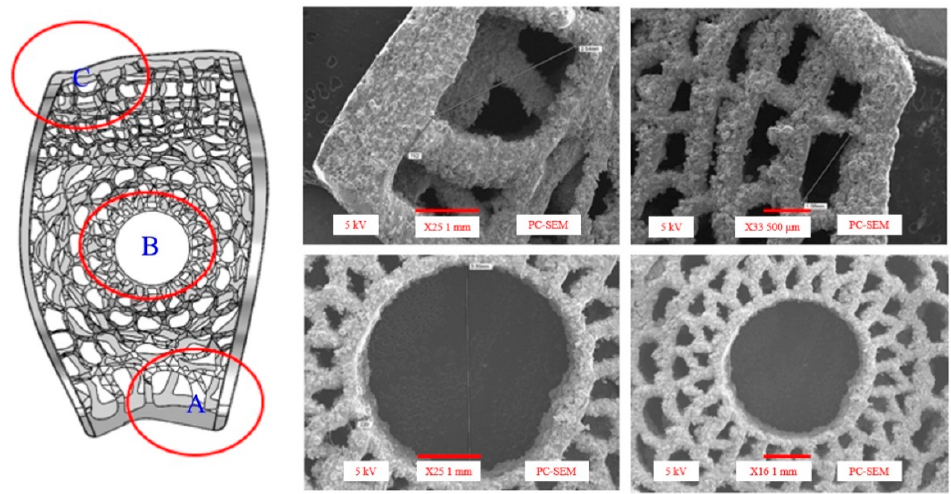
Figure 9. The scanning electron microscope (SEM) photograph for specimens.